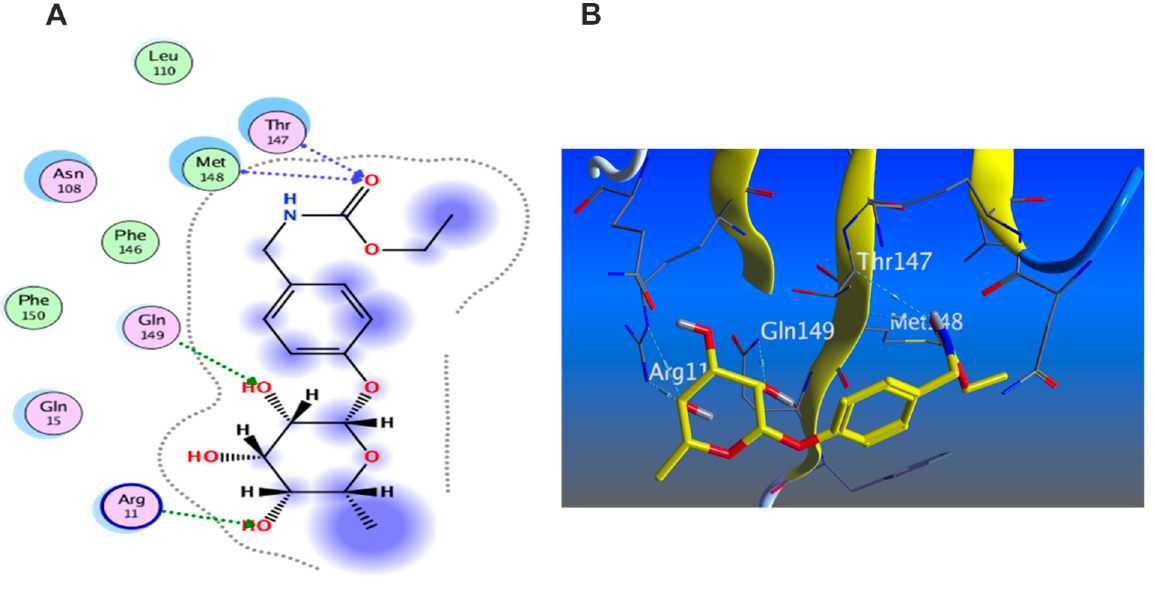
Figure 17. Docking results of compound 16 in the active pocket site of IL-1 β (PDB:6Y8M): ( A ) 2D interactions of compound 16 ( B ) 3D Docking pose of compound 16 .